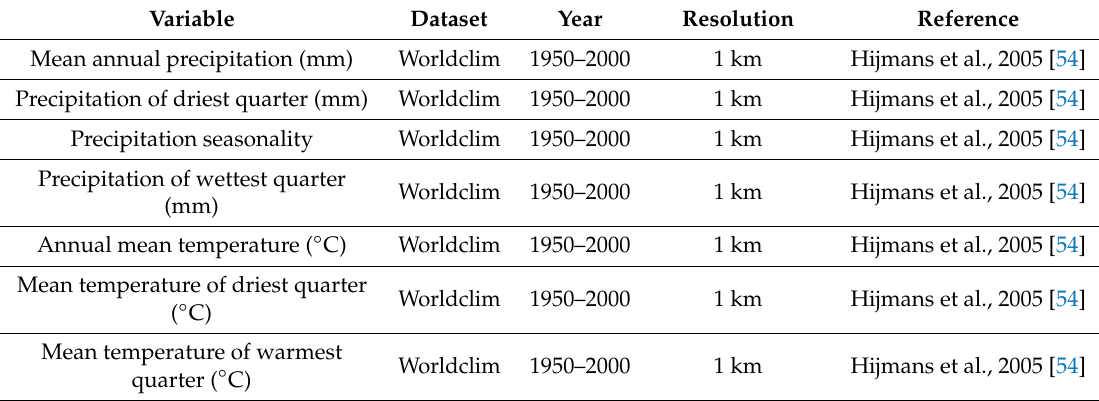
Figure 1. The workflow for producing global mangrove aboveground biomass map based on the multisource remote sensing data and ground observation data. Table 1. The variables used in the random forest method to determine GLAS parameters and model mangrove aboveground biomass.